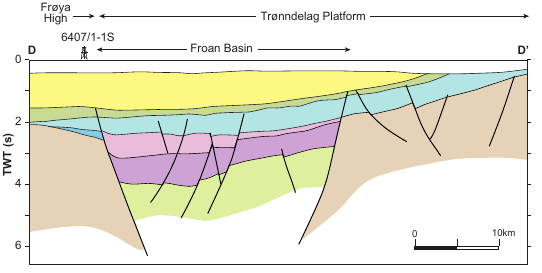
Figure 10. Geoseismic profile across the southern Froan Basin. Modified from Blystad et al. (1995). Location of profile in Fig. 8 and colours as in Fig. 9. Well, 6407/1-1S that encountered Upper Permian carbonates above basement on the Frøya High is projected onto the